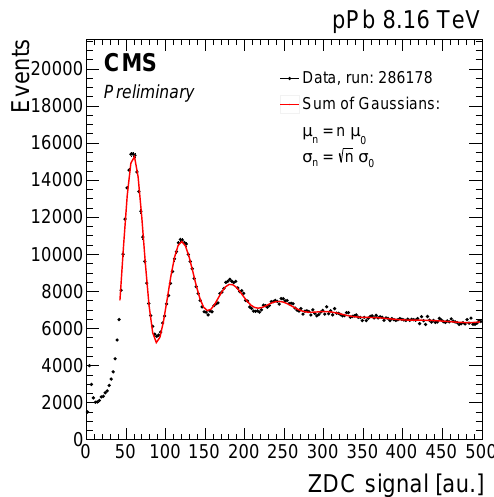
Figure 4. The low end of ZDC signal distribution. The peaks correspond to events with one, two and three neutrons detected by the ZDC respectively. The position of the first peak corresponds to 2.56 TeV, the energy of nucleons in the Pb ion for 8.16 TeV pPb collisions